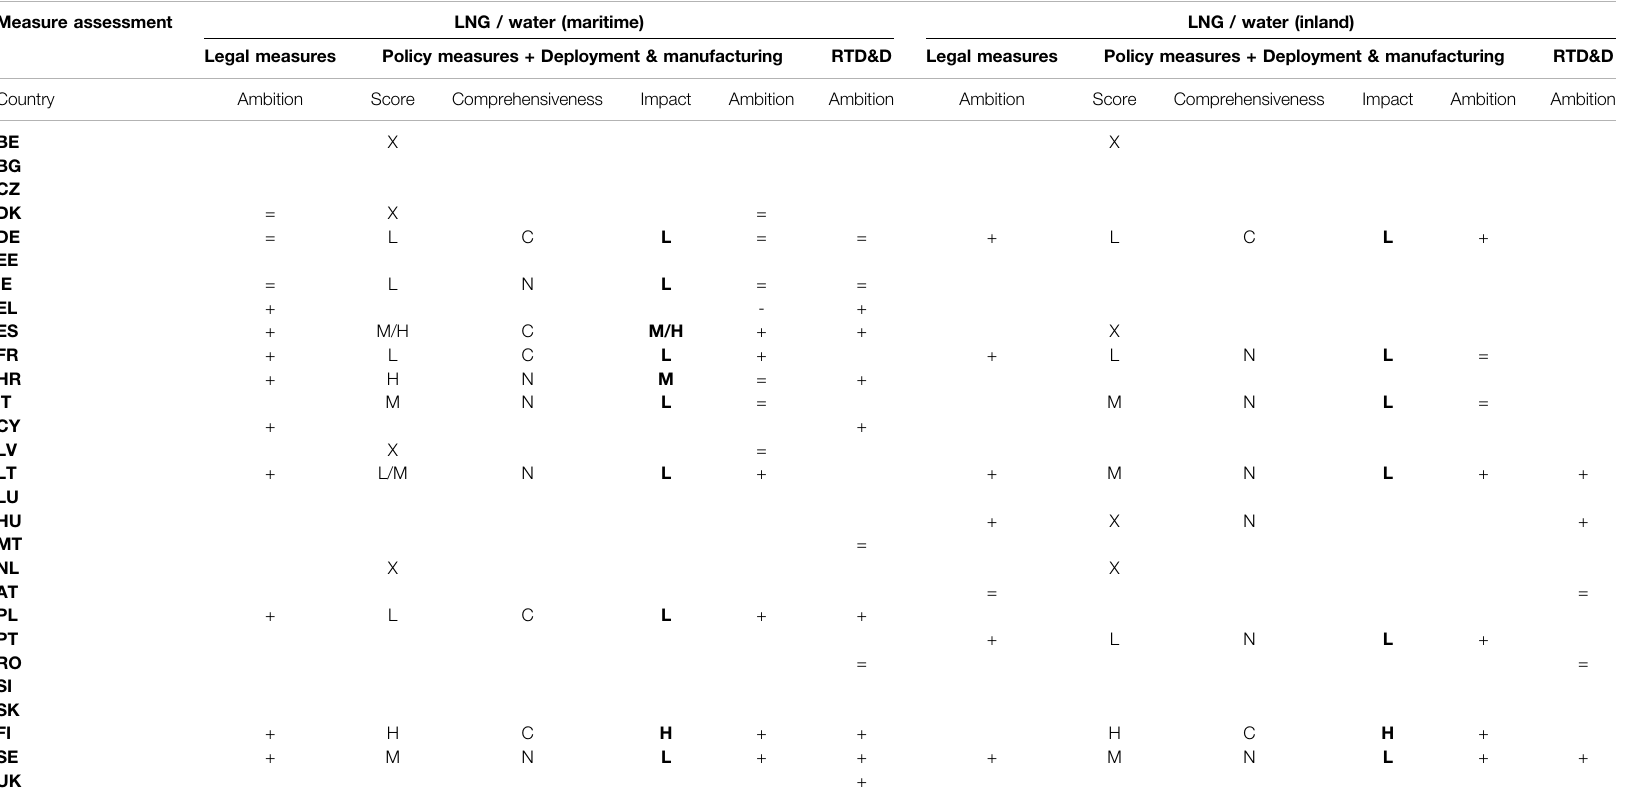
TABLE 2 | Results of the measure assessment for vessels powered by